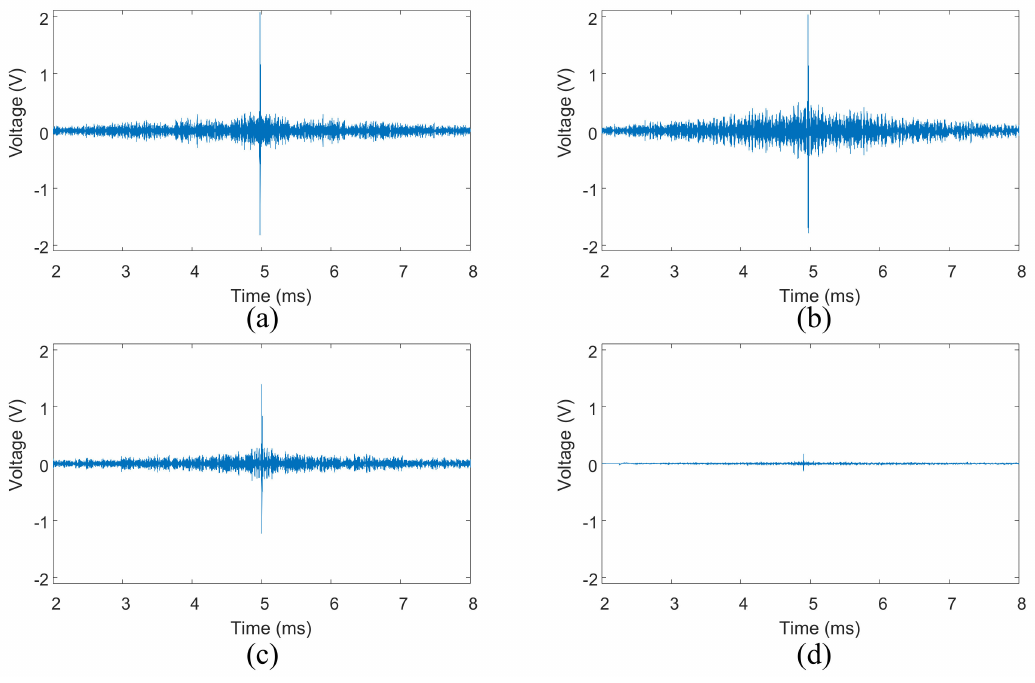
Figure 9. Reconstructed signals using TR method acquired from four-bolt structure: ( a ) reconstructed signal with 8 Nm torque of bolt 2; ( b ) reconstructed signal with 1 Nm torque of bolt 2; ( c ) reconstructed signal under loosening case 5; ( d ) reconstructed signal under loosening case 1.